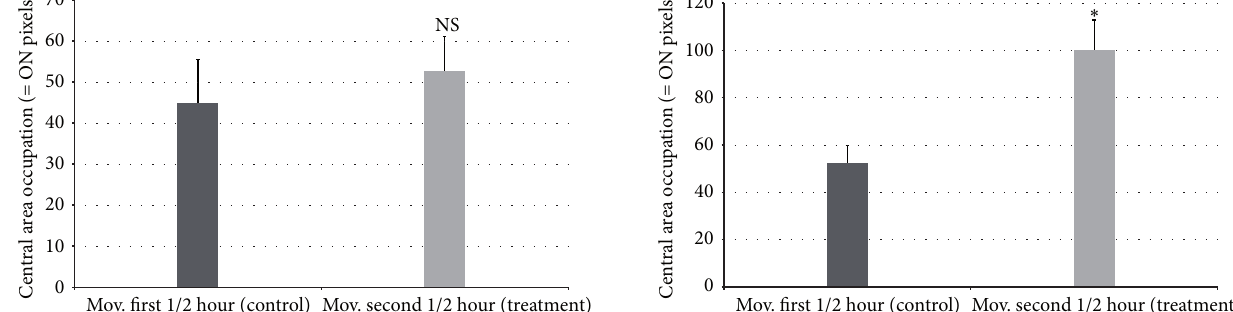
Figure 4: Response of male Megaplatypus mutatus measured as the central area occupation (= on pixels) for 𝛼 -copaene compared to its respective control. Each bar represents the mean of 10 independent replicates ± SE. ∗ : significant differences between treatment and control group (Kruskal-Wallis Test, 𝑃 < 0.01